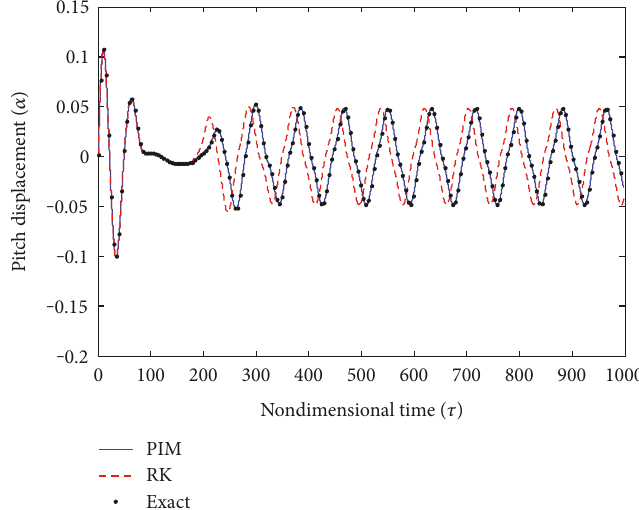
=0.8 (a) for pitch and (b) for plunge direction, respectively. 0